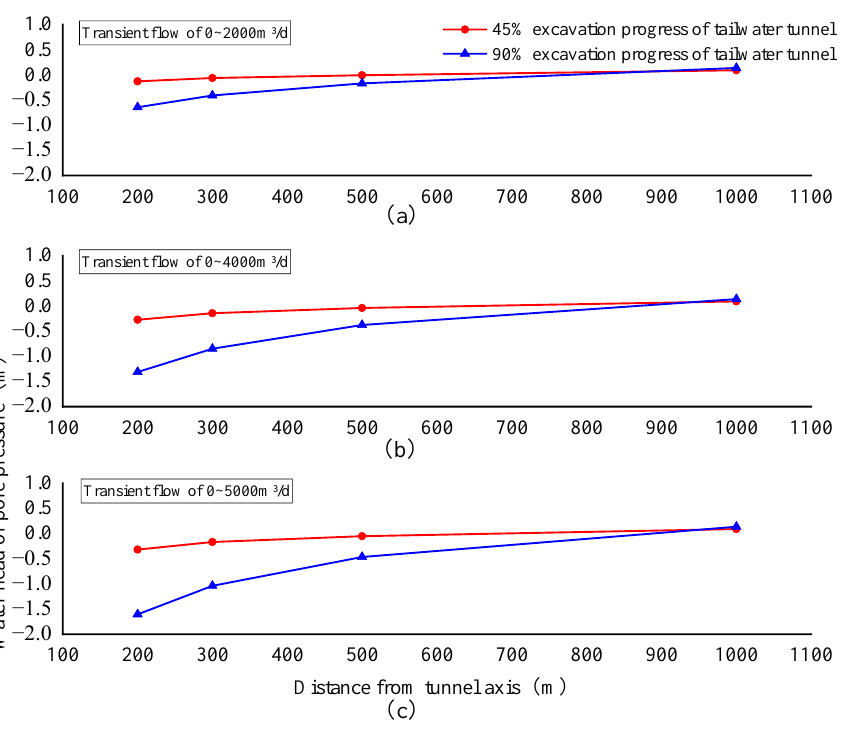
Figure 15. Variations in the water level under limiting seepage conditions. (( a ) is change in water level of the maximum water inflow of 2000 m³/d, ( b ) is change in water level of the maximum water inflow of 4000 m³/d, ( c ) is change in water level of the maximum water inflow of 5000 m³/d)